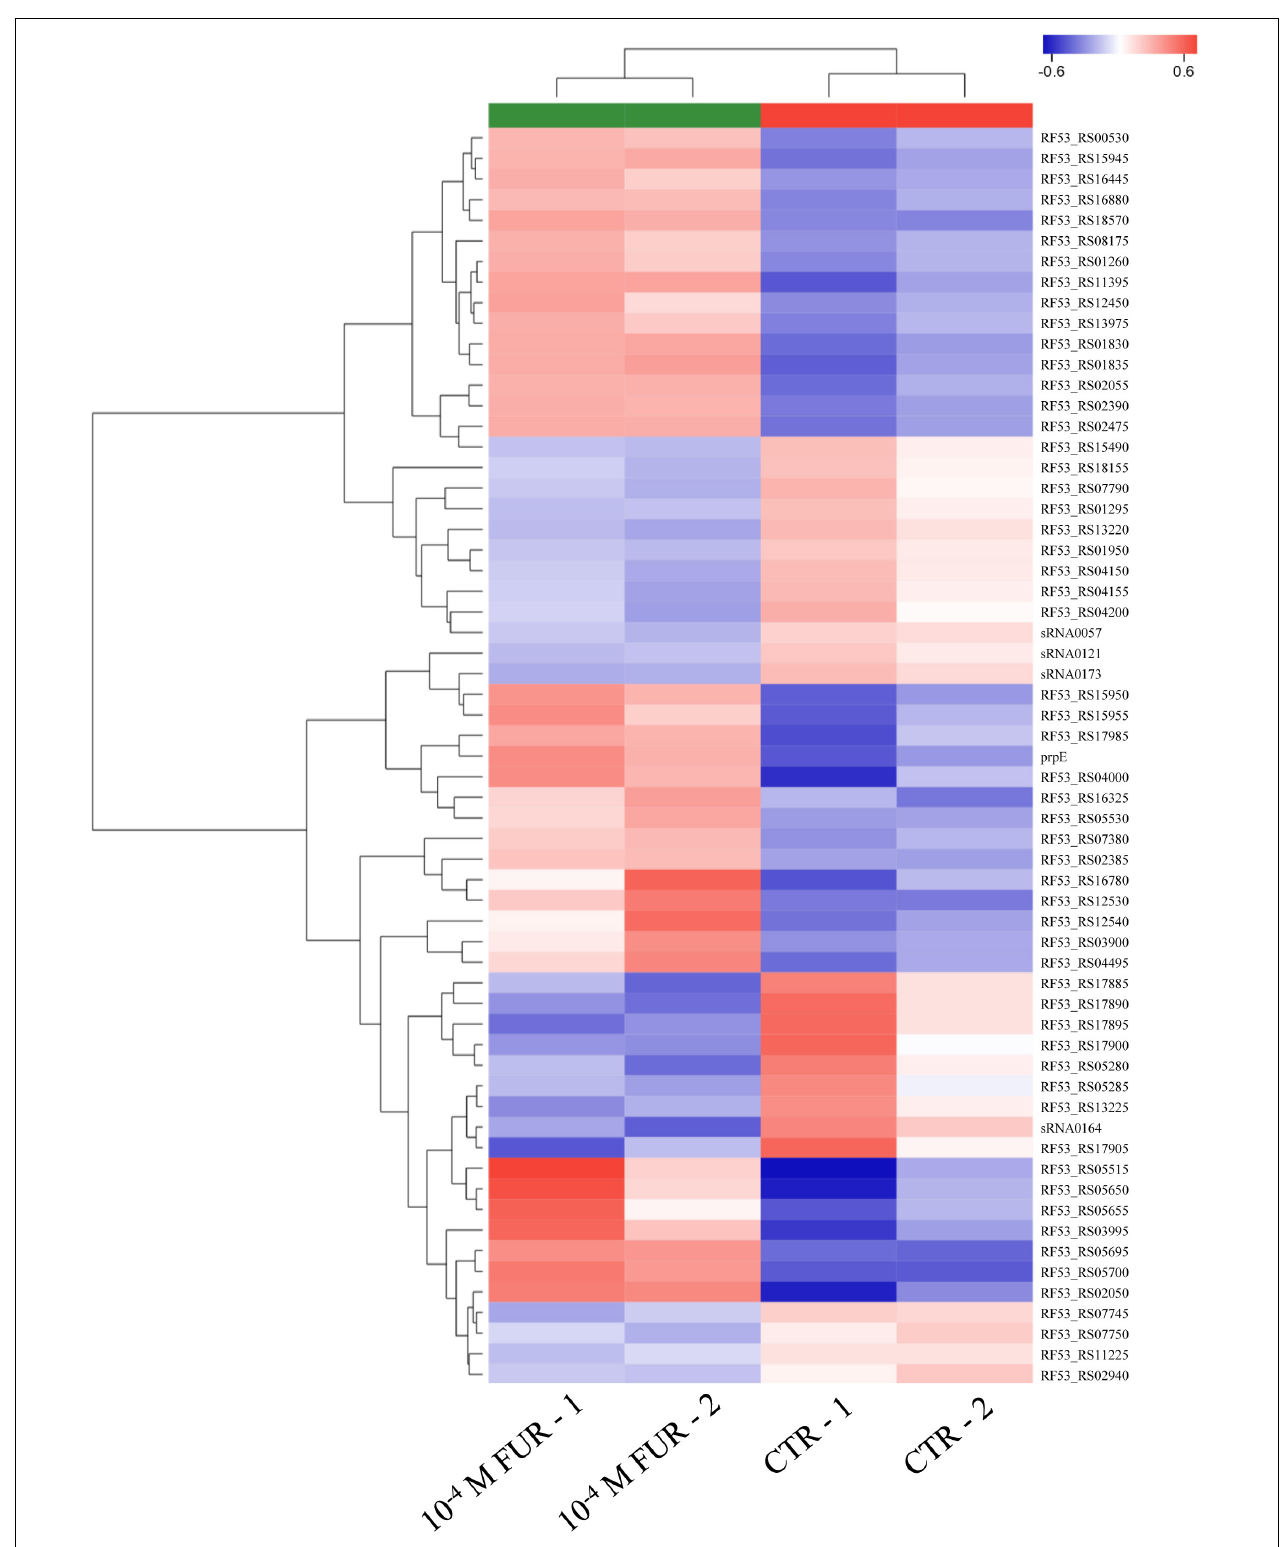
FIGURE 4 | Heat map of the DEGs identified in RNA-seq data in CTR and FUR-treated biofilms are shown. The gene names are shown on the right side of the heat map. The gene clustering is shown on the left side. Control (CTR), P. marina ECSMB14103 biofilm prepared on a sterile glass slide without adding FUR; FUR, 10 4 M FUR treated P. marina ECSMB14103